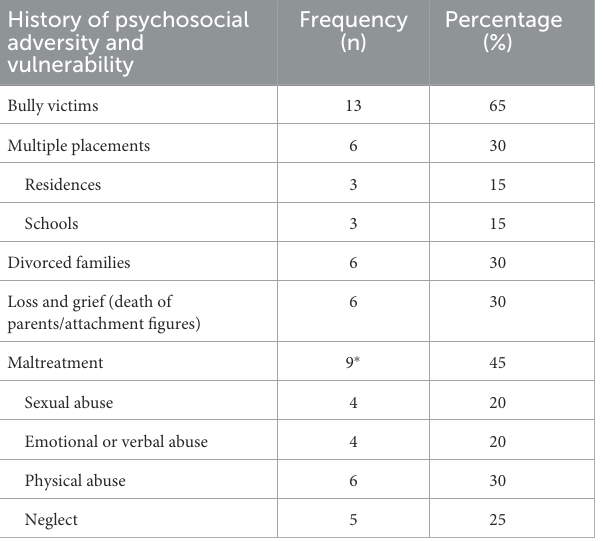
TABLE 3 History of psychosocial adversity and vulnerability. History of psychosocial adversity and